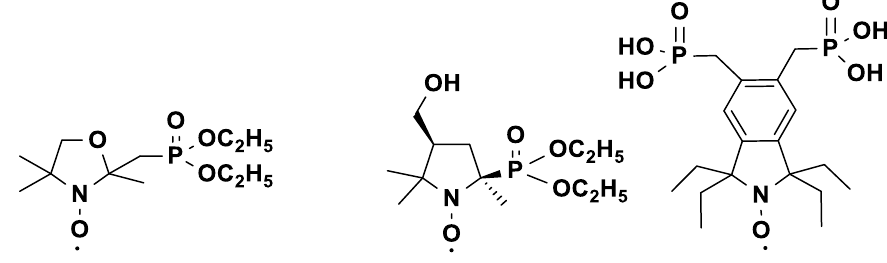
Figure 1. Previously reported paramagnetic phosphonates.